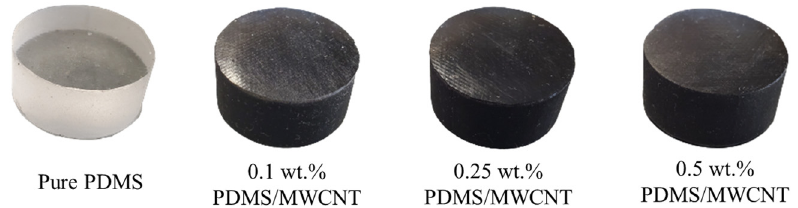
Figure 3: Actual fabricated samples: Pure PDMS and PDMS/MWCNT nanocomposites with di ff erent MWCNT